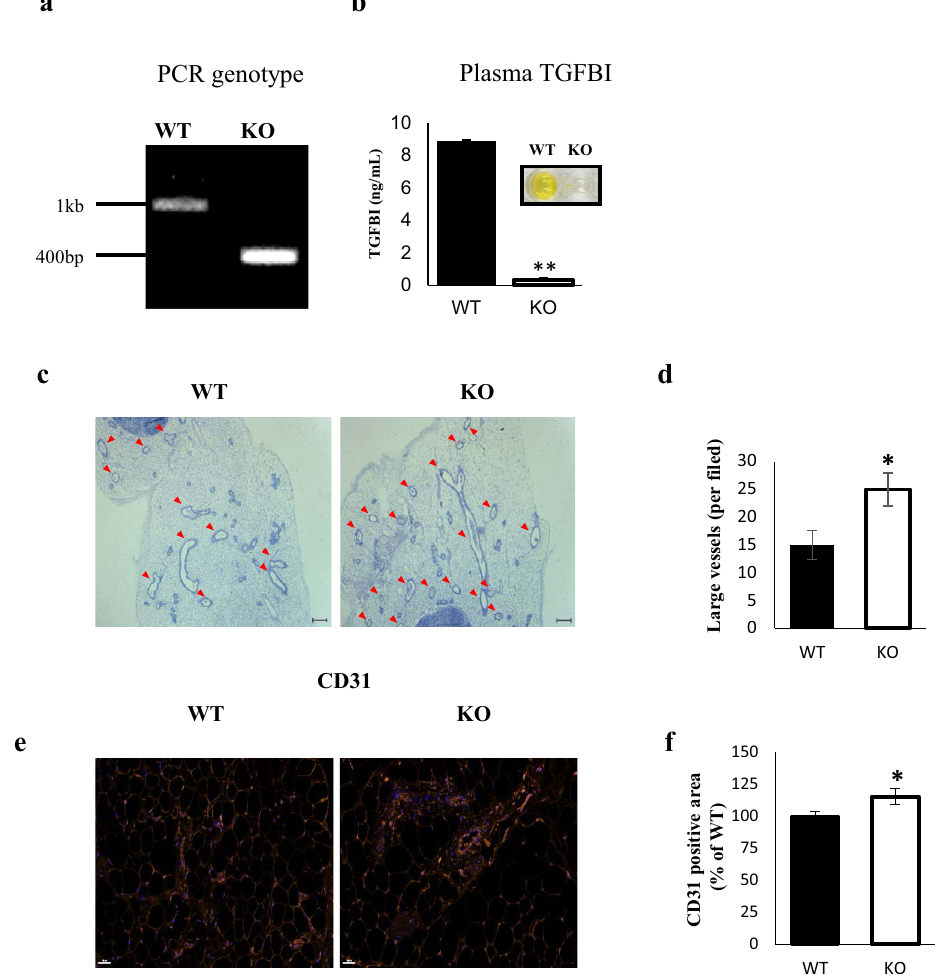
Figure 1. TGFBI KO mice show higher vessel density in adipose tissue compared with WT mice. (a) Genotyping was performed using PCR. The amplification targeted exon 3 of the TGFBI gene. (b) Plasma TGFBI concentrations in 20-week-old WT and KO mice (n = 3/group). (c) Representative H&E staining of iWAT sections from 20-week-old male WT and KO mice (n = 5/group). The red arrow indicates a large vessel (≥ 10 µm in diameter). Scale bars represent 200 μm. (d) The vessels were counted in sections from three mice, and expressed as mean number. (e,f) Representative images of CD31 immunohistofluorescence staining of iWAT from 20-week-old male WT and KO mice (n = 5/group). Scale bars represent 50 μm. (f) Quantification of area percentage of CD31 staining using ImageJ software. Data are presented as the mean ± S.E.M. *p < 0.05 versus